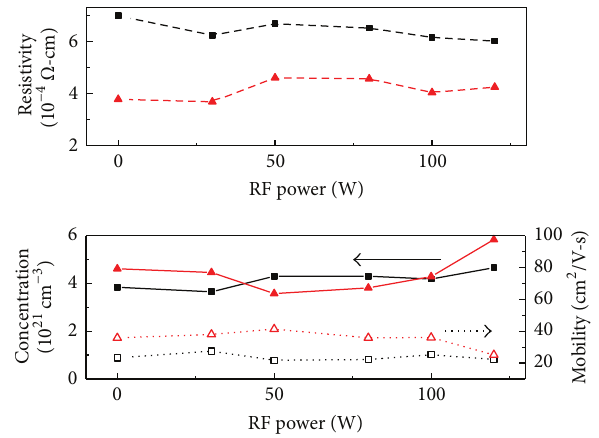
Figure 5: The electrical property of the sputtered AZO film versus the RF power.